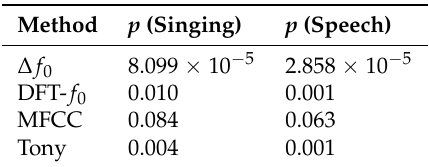
Table 6. p -value of the results of the proposed optimized algorithm compared with the rest of the